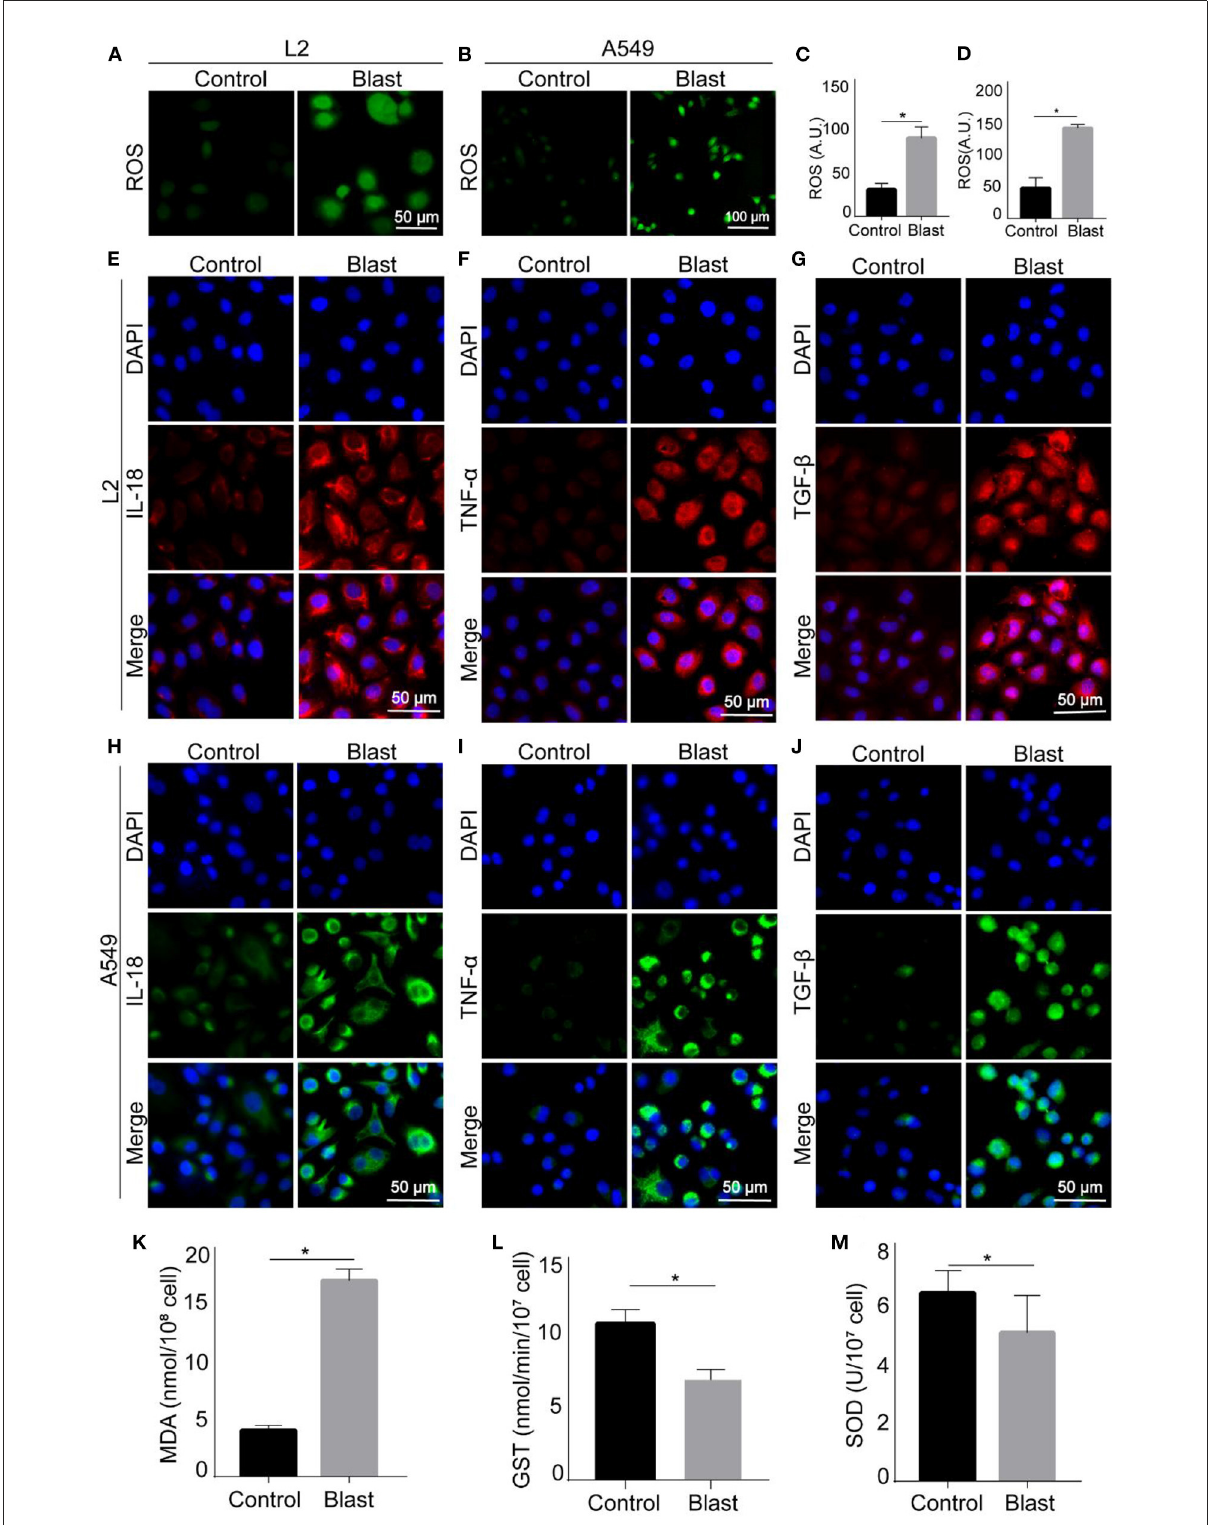
FIGURE5 Oxidative stress and inflammatory response of blast wave stimulated alveolar epithelial cells. (A, B) Representative images of immunofluorescence staining showing the content of ROS in L2 and A549 cells. (C, D) Quantitative analysis and comparison of intracellular